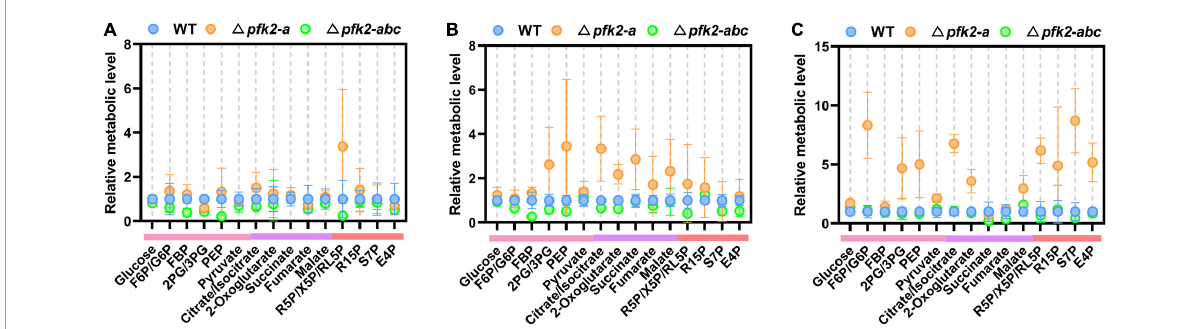
FIGURE3 Intracellular metabolite profiling of intermediates involved in central metabolic pathways in the WT, (cid:49) pfk2-a , and (cid:49) pfk2-abc strains. Metabolites from the EMP pathway (pink lines), TCA cycle (purple lines), and PPP (red lines) on days 2, 3, and 4 are shown in panels (A–C) . The concentrations of extracted intracellular intermediates were measured by LC–MS/MS, and the relative level of each metabolite in the (cid:49) pfk2-a and (cid:49) pfk2-abc strains was calculated by dividing its normalized peak area by that in the WT strain. Values and error bars represent means and standard deviations of independent triplicate experiments, respectively. F6P, fructose-6-phosphate; FBP, fructose-1,6-diphosphate; 2PG, 2-phosphoglycerate; 3PG, 3-phosphoglycerate; PEP, phosphoenolpyruvate; R5P, ribose-5-phosphate; X5P, xylulose-5-phosphate; RL5P, ribulose-5-phosphate; R15P, ribulose-1,5-bisphosphate; S7P, sedoheptulose-7-phosphate; E4P,